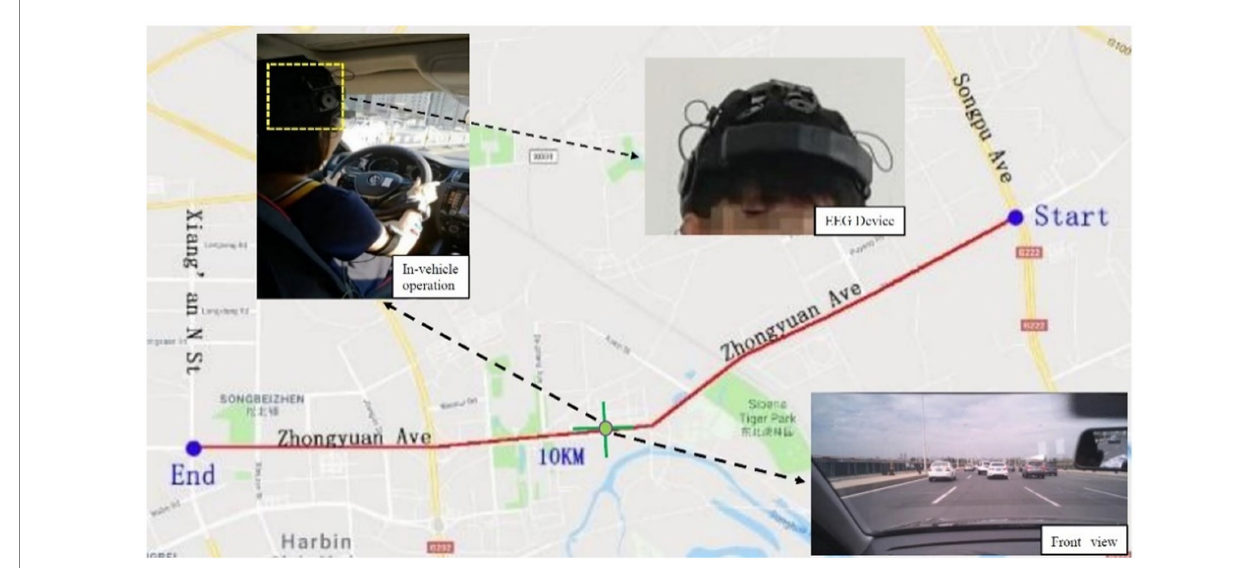
FIGURE 1 Experiment routes and the traffic environment.